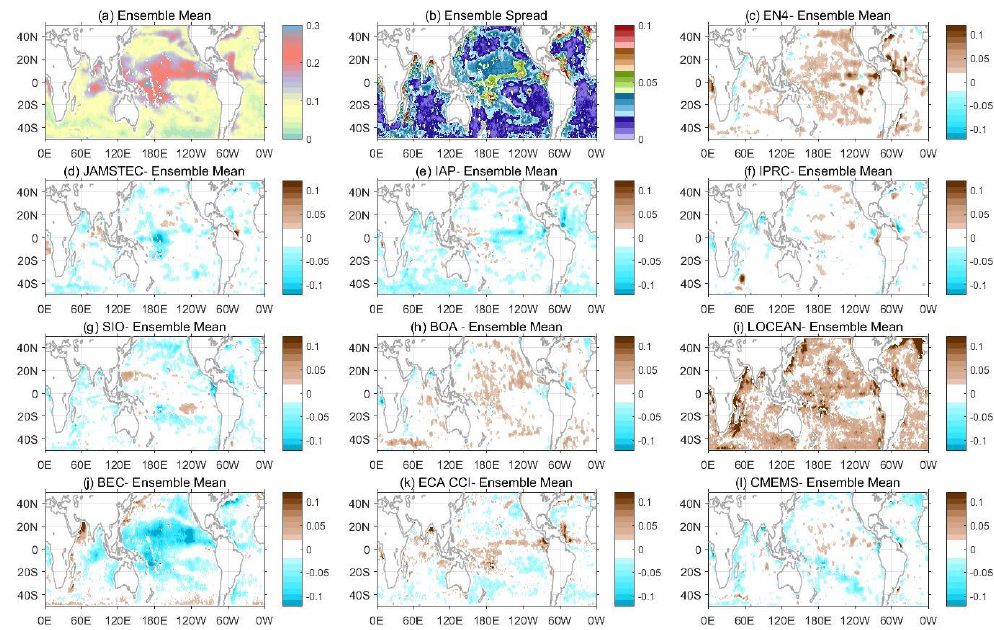
Figure 11. ( a ) The STD of the ensemble mean of the interannual SSS. ( b ) The spread of STD of the interannual SSS time series based on ten products. ( c – j ) The difference between the STD of the interannual SSS signal from individual products and the ensemble mean. The blue lines in ( a – l ) denote the major rivers worldwide.